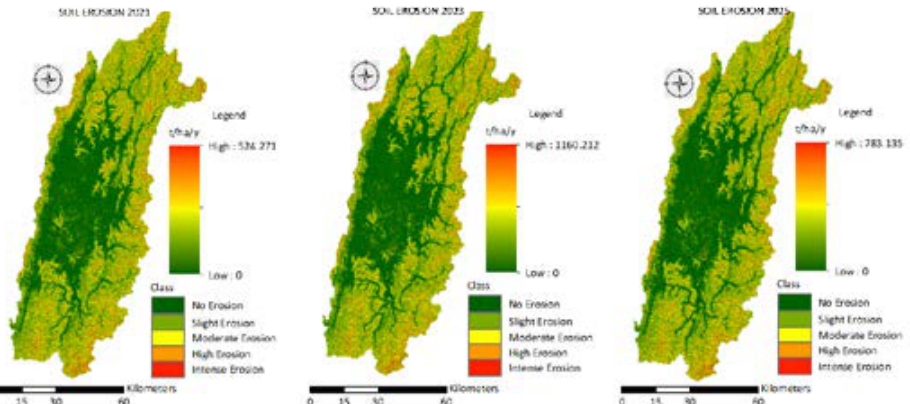
Fig. 7: Soil erosion classes map for the year 2021, 2023 and 2025